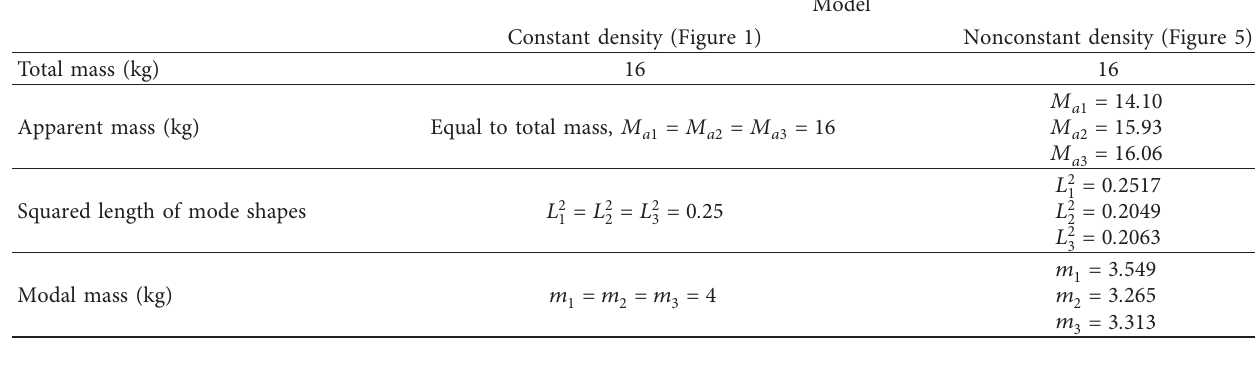
Table 1: Modal masses, effective masses, and length of mode shapes for the cantilever